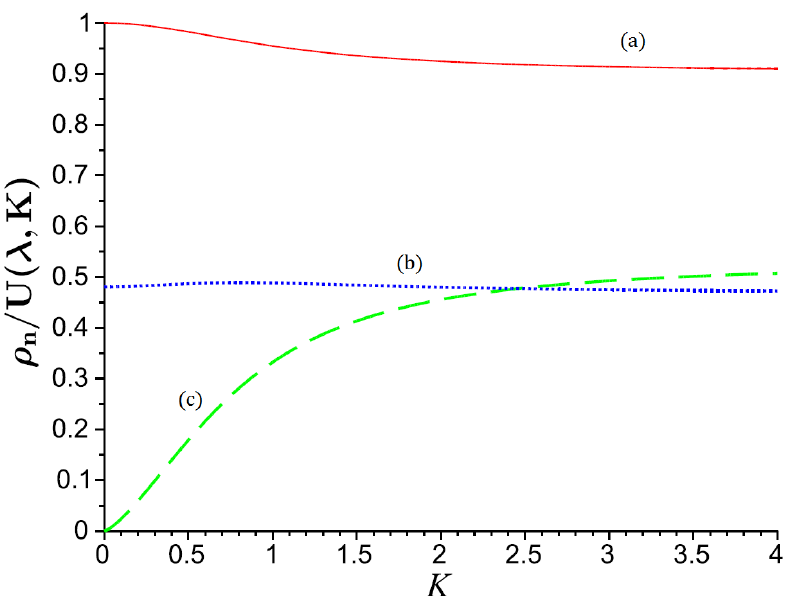
Figure 5. Pierce parameter ( ρ n ) vs. K; ( a ) ( 1 ) x continuous line ( b ) ( 2 ) y dot line ( c ) ( 3 ) x dash U ( λ , K )